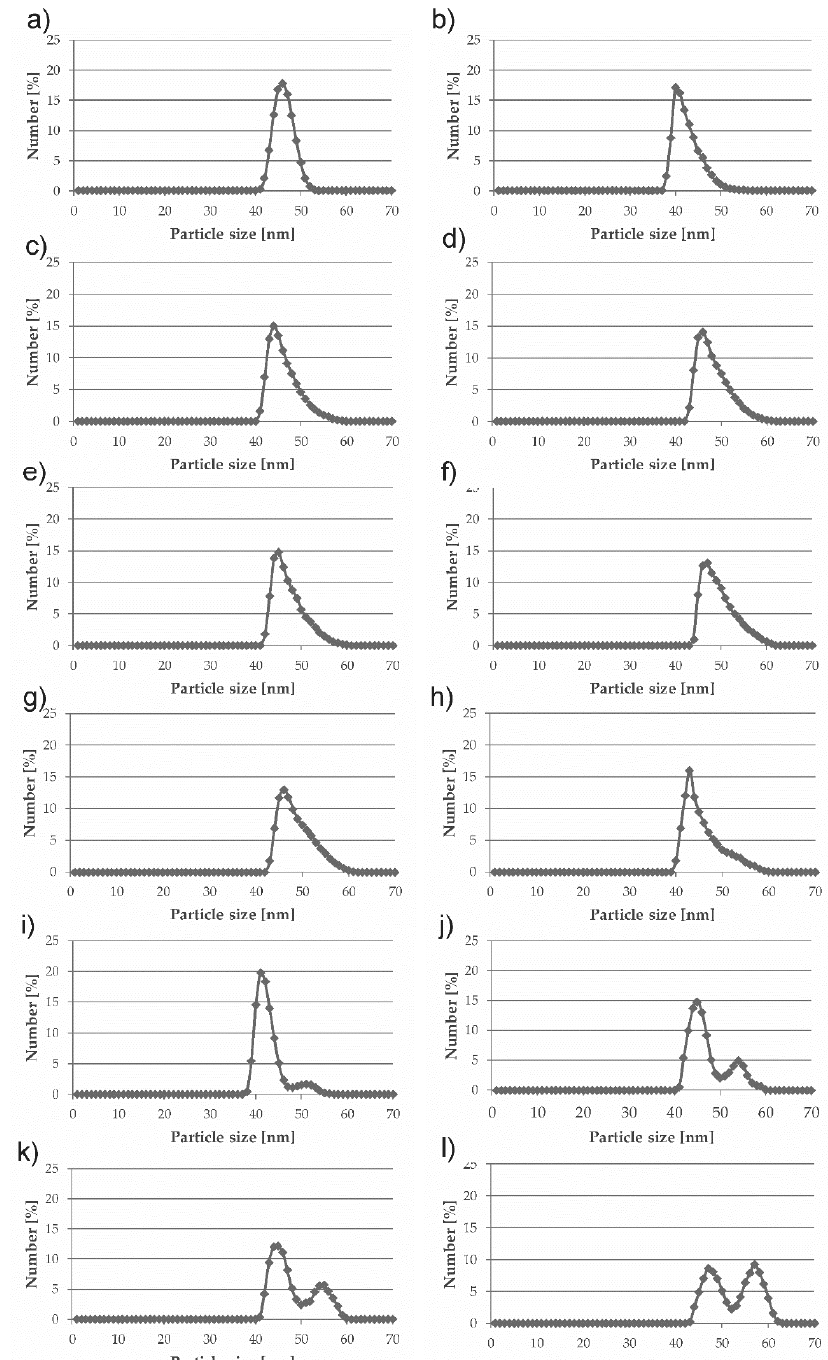
Figure 1. Zeta sizer results for modified liquid component that was subsequently mixed with powder, with a nanoparticle content of: ( a ) 0.02%; ( b ) 0.05%; ( c ) 0.1%; ( d ) 0.2%; ( e ) 0.5%; ( f ) 0.7%; ( g ) 1%; ( h ) 1.5%; ( i ) 2%; ( j ) 2.5%; ( k ) 3%; ( l )